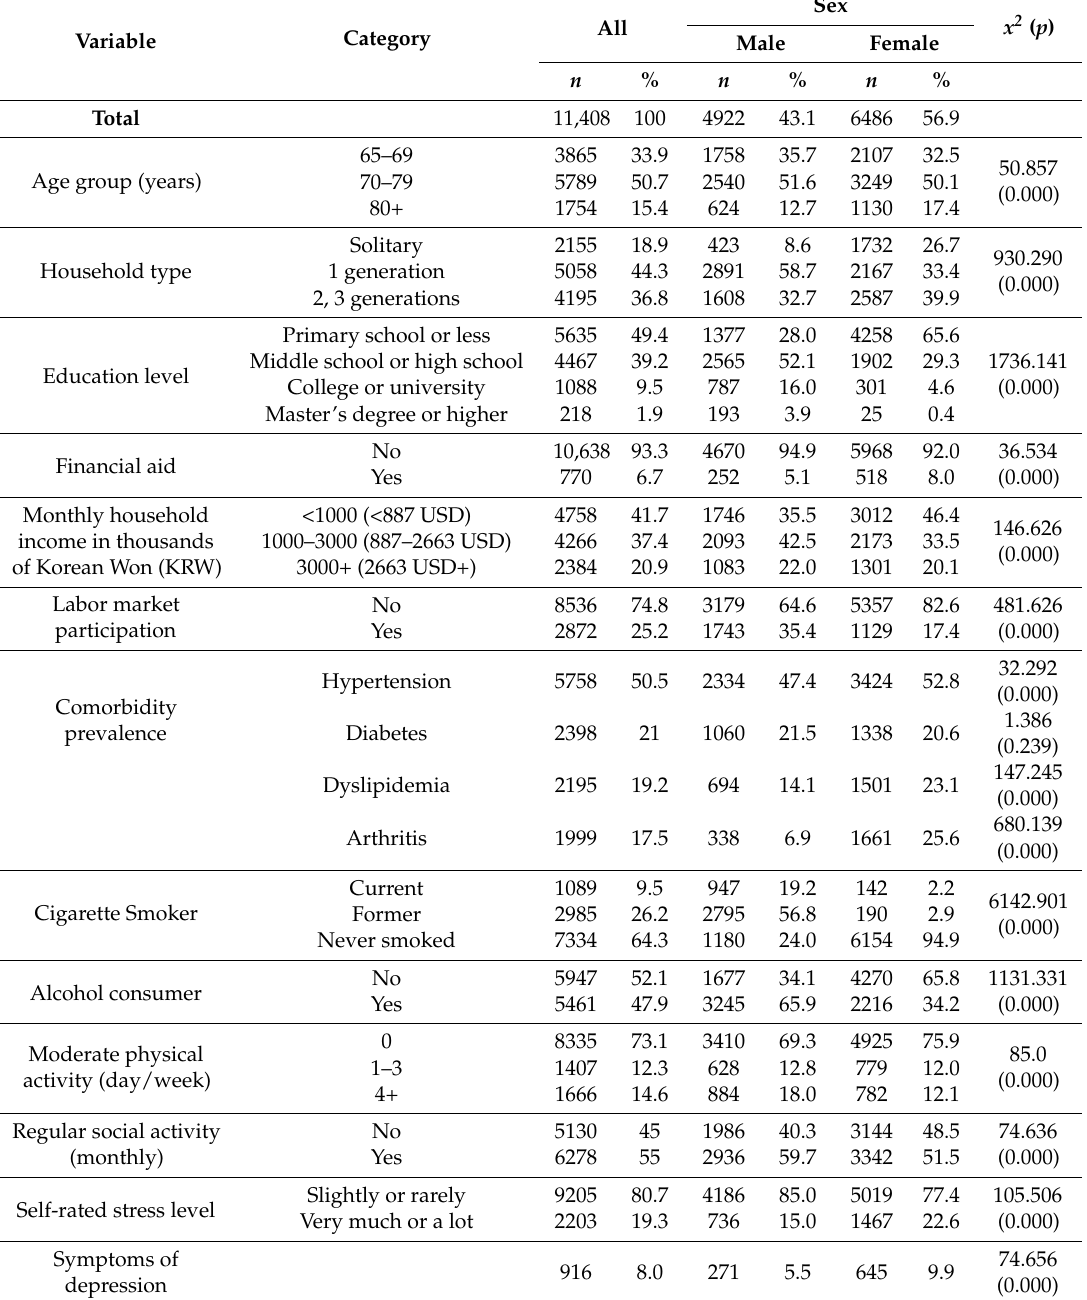
Table 1. Descriptive characteristics of the study sample: 2015 Korean community health survey ( n =